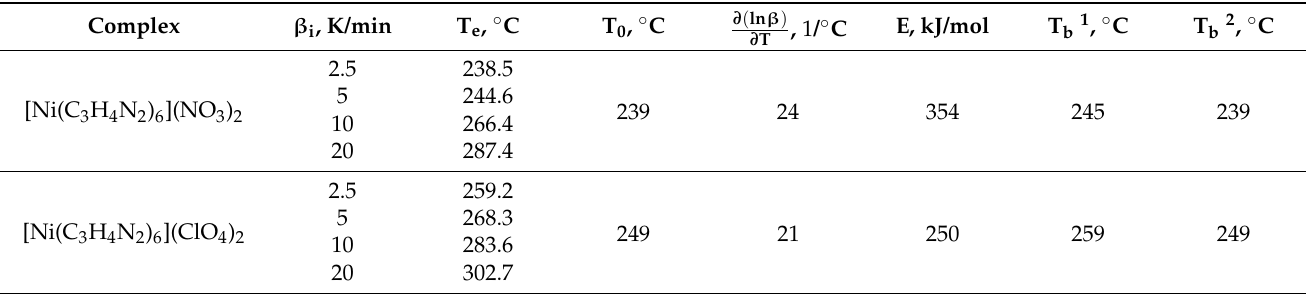
Table 3. The critical temperature of thermal explosion for [Ni(C 3 H 4 N 2 ) 6 ](NO 3 ) 2 and [Ni(C 3 H 4 N 2 ) 6 ] (ClO 4 ) 2 complexes.